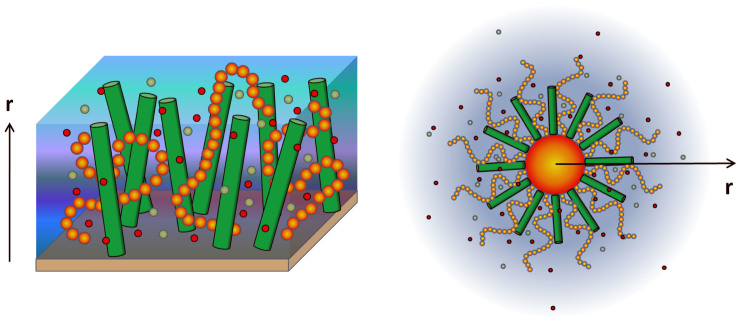
Schematic of two DNA surface systems: planar surface (left) and spherical surface (right).Anchored green rods represent dsDNA while yellow sphere-linked chains represent ssDNA. Red and green small spheres are cations and anions respectively.